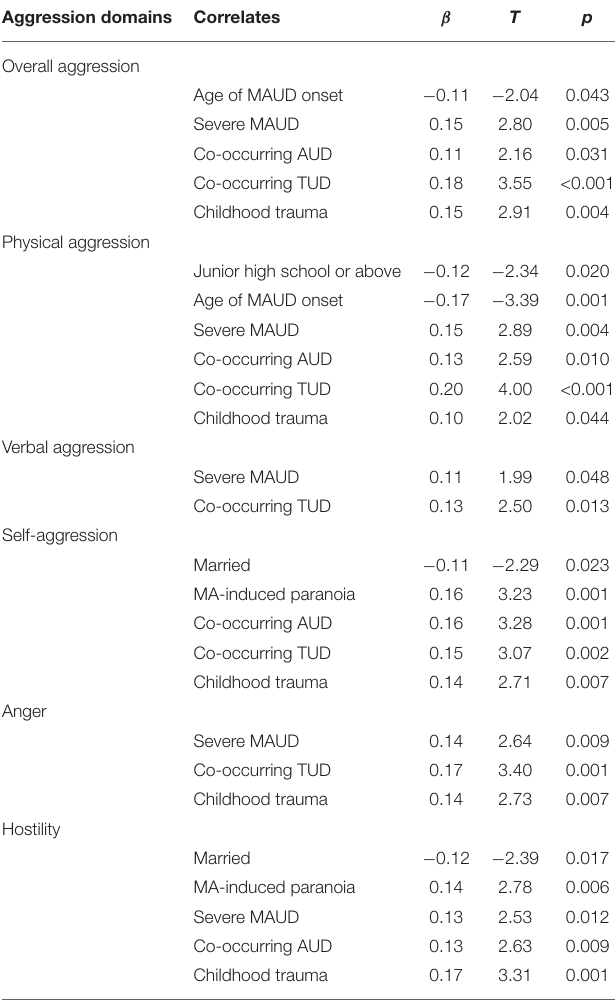
TABLE 3 | Multivariate linear regression analyses of aggression. Aggression domains